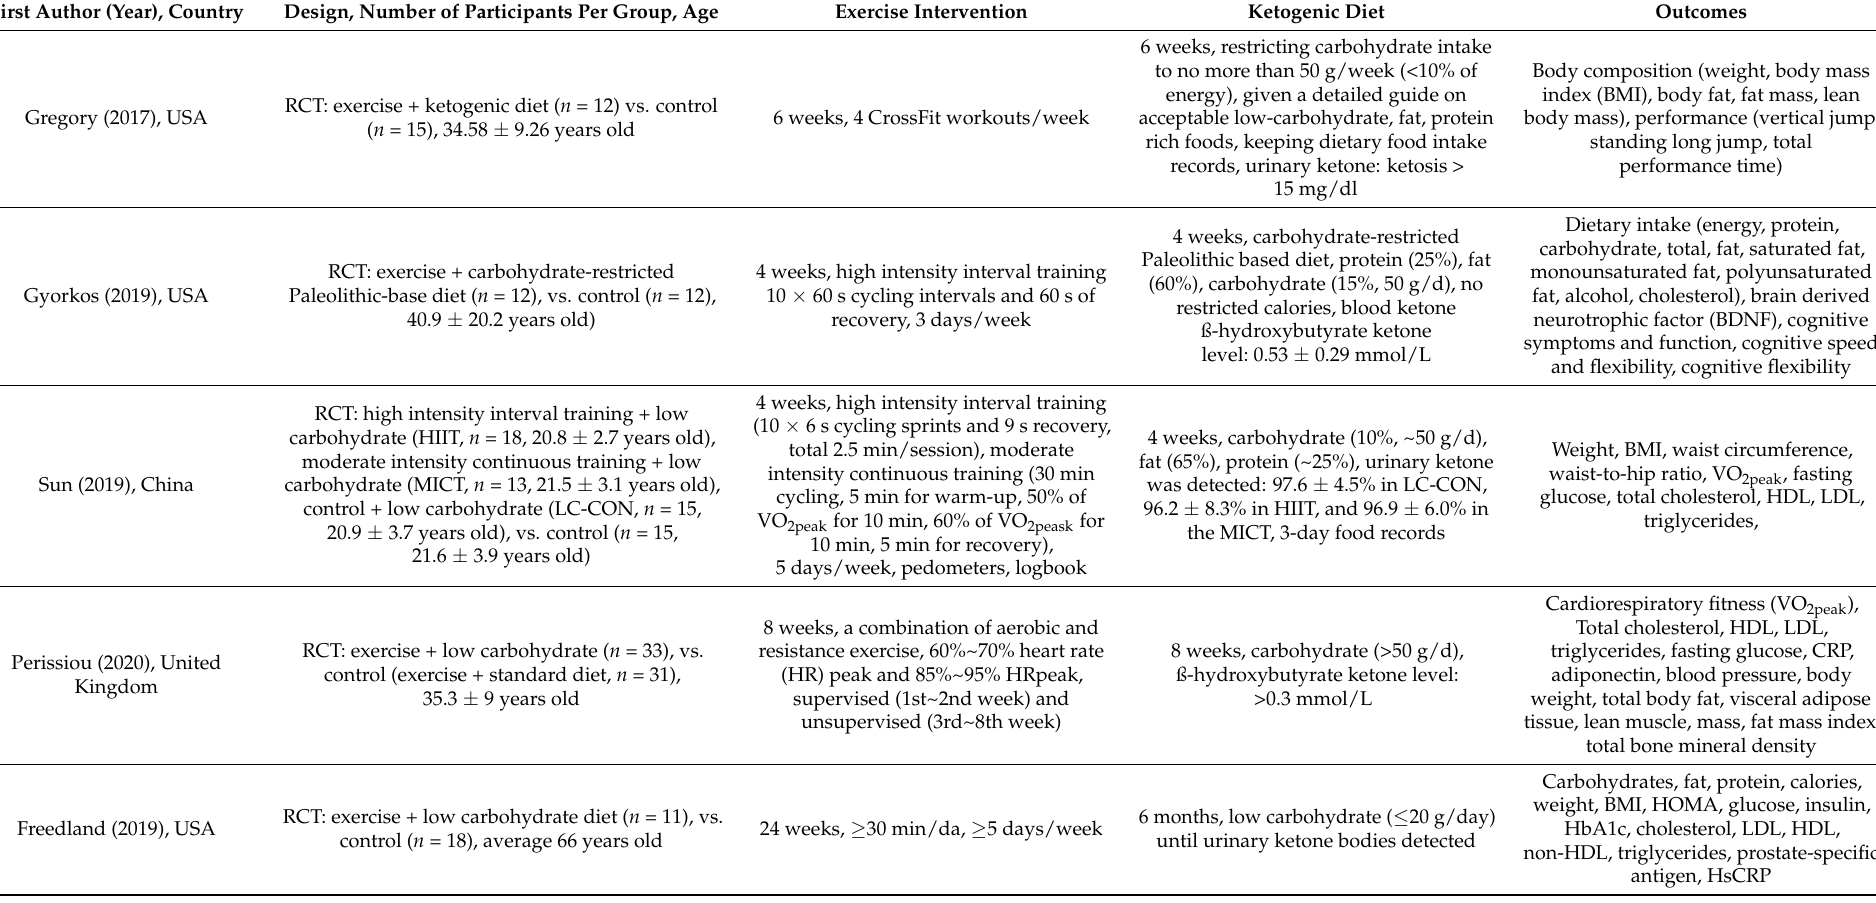
Table 1. Basic characteristics of selected